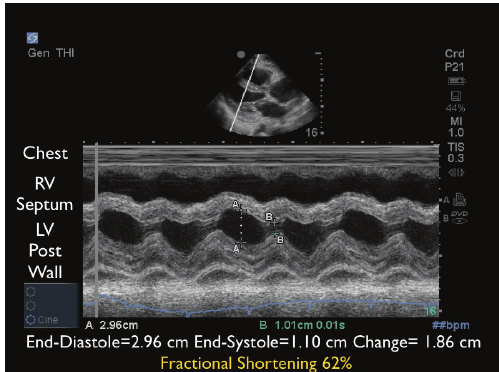
Figure 8: M-mode tracing demonstrating excellent contractility. RV: right ventricle, LV: left ventricle.